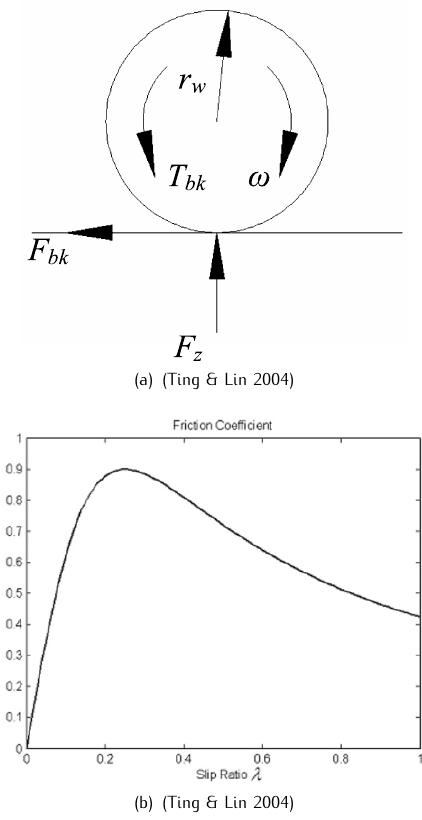
the friction torque, T is the braking torque applied by the b disk/drum brakes, r is the wheel radius, µ is the friction w coefficient between the tyre and the road, λ is the tyre slip ratio, λ is the optimal slip ratio, which can yield the o peak friction value µ ( λ ) = µ , F is the vertical normal o o z forces of the tyres, v is the vehicle body velocity, and v is w the equivalent wheel longitudinal velocity. The subscript k indicates the wheel’s location ( f R : front right wheel, f L : front left wheel, r : rear right wheel and r : rear left R L wheel). The wheel rotational angle can be calculated after the integration of Equation (1), and then the estimation of the slip ratio λ can be driven. The values of the slip ratio are then used to feed the ABS controller. This controller compares the error between the desired slip ration (from 0.18 to 0.3) and the estimated one. Relative to the error comparison, the ABS controller turns the brake on/off which controls the braking torque T to sustain the coefficient of b friction µ at its maximum values ( µ ), therefore the maximum o braking force can be